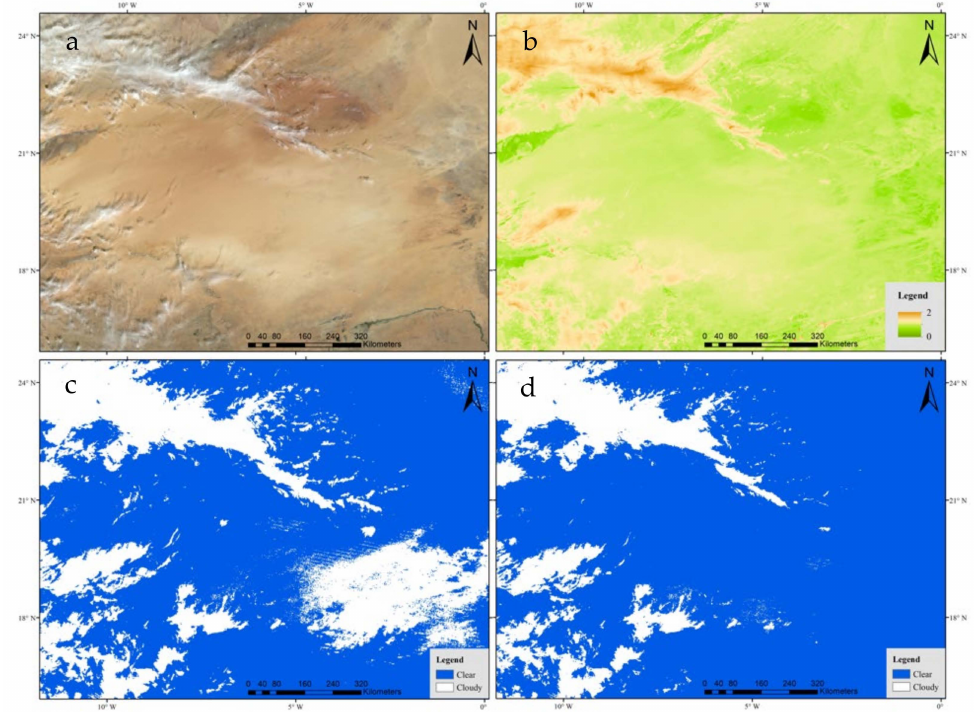
Figure 15. Correction effect of Band 2/6 ratio threshold method. ( a ) True-color image of Sahara Desert (band 1, 4, 3) on 1 January 2008; ( b ) the ratio of Band 2 and Band 6 image of Sahara Desert;